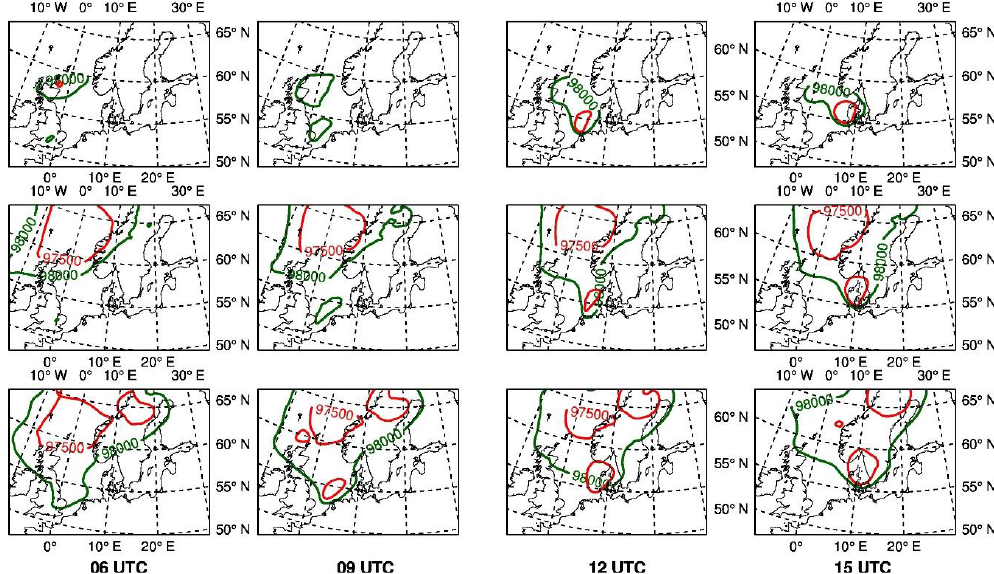
Figure 9. Evolution of three-hourly mean sea level pressure MSLP (Pa) of CCLM1 ( top ), CCLM4 ( middle ), and ERA5 ( bottom ). Time period: 06–15 UTC on 28 October 2013. Green contour is the line of 980 hPa. Red contour is the line of 975 hPa.